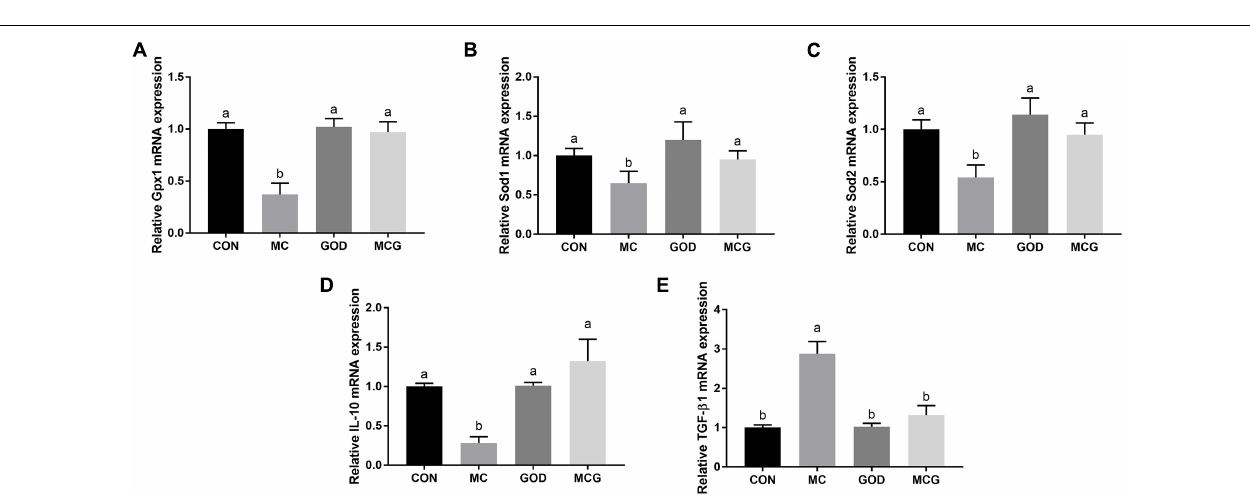
FIGURE 4 | Effects of glucose oxidase on intestinal mRNA expression of antioxidative stress- and inflammation-associated genes in the broiler chickens fed mold contaminated corn. Relative expression of Gpx1 (A) , Sod1 (B) , Sod2 (C) , IL-10 (D) , and TGF- β 1 (E) . a , b Means with different letters within columns indicates significant differences at P ≤ 0.05. n =